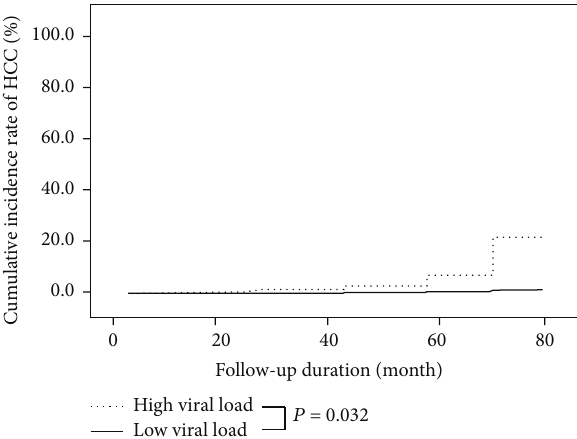
Figure 2: Cumulative incidence of hepatocellular carcinoma according to the viral load of serum HCV RNA. The cumulative incidence rate of HCC in patients with high viral load (log HCV RNA IU/mL > 6) was significantly higher than that in patients